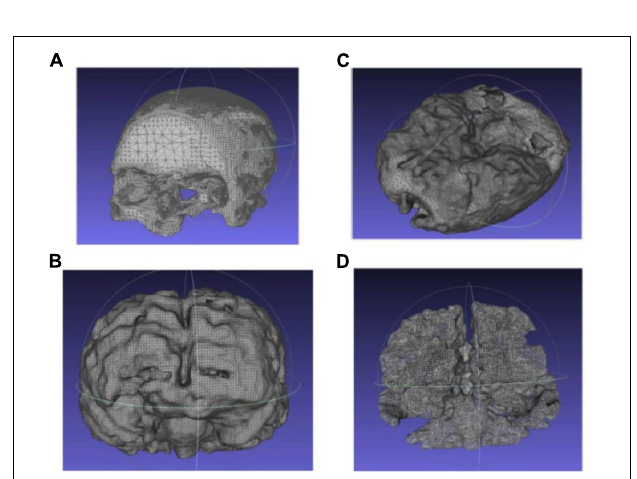
FIGURE 5 | Extracted and processed tissue models from the MRI image stack (A) skull, (B) CSF, (C) gray matter, and (D) white matter.